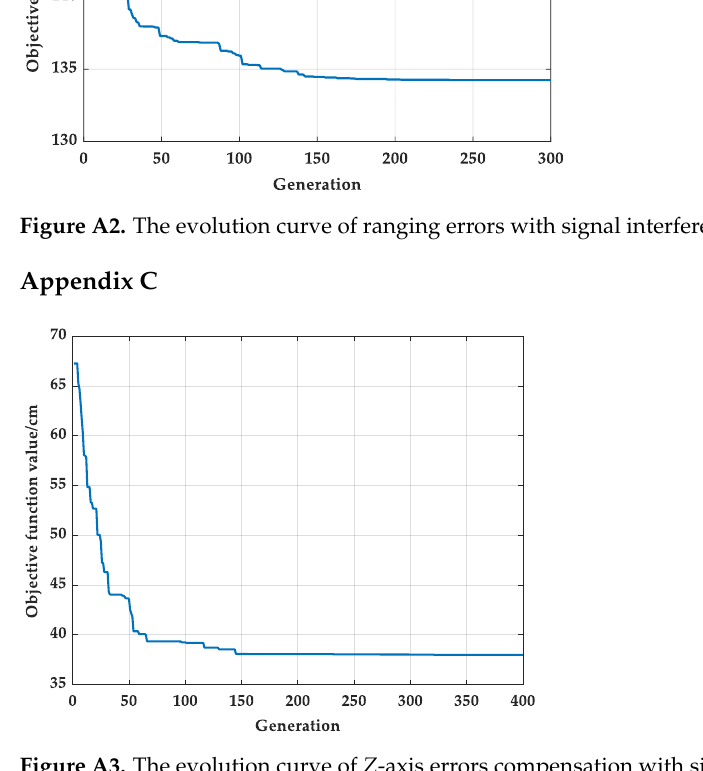
Figure A3. The evolution curve of Z -axis errors compensation with signal interference.